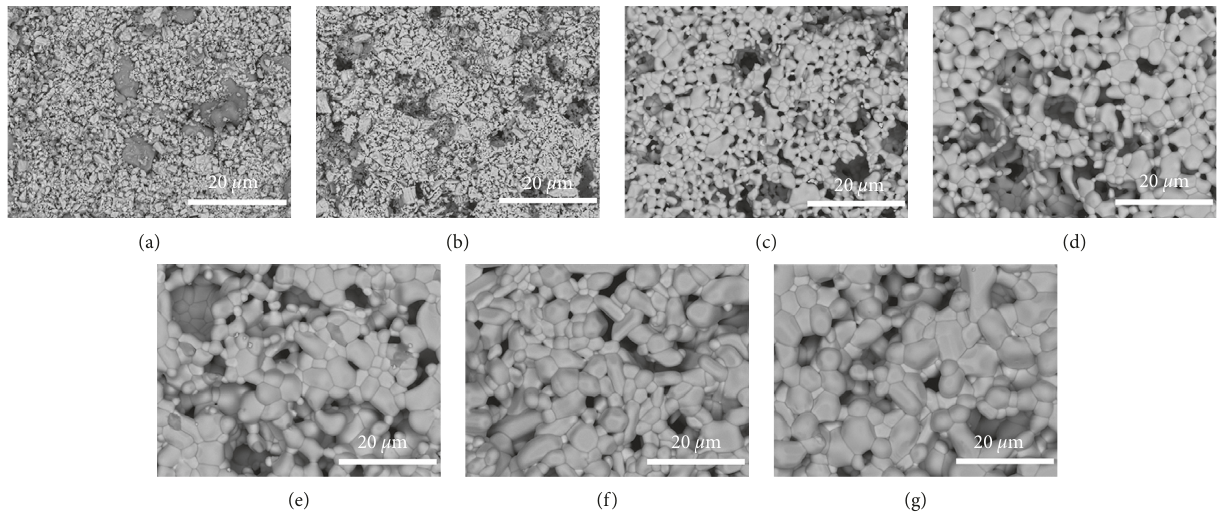
Figure 3: The SEM pictures of the PSPP with the same initial new solid phase (Gd (unsintered), (b) sintered at 950 ° C, (c) 1000 ° C, (d) 1050 ° C, (e) 1100 ° C, (f) 1150 ° C, and (g) 1200 °